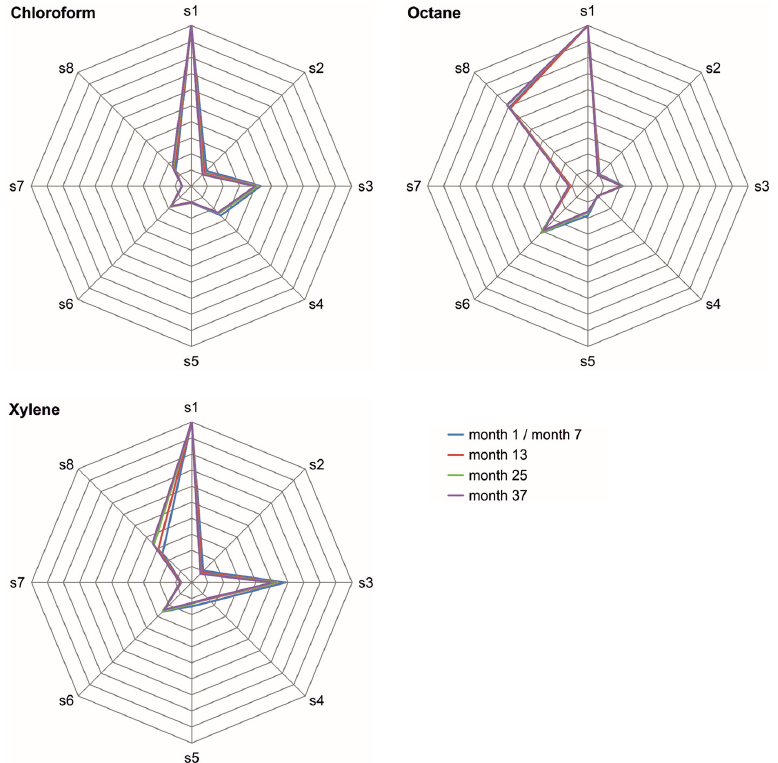
Figure 9. Radar charts of chloroform, octane, and xylene samples obtained at (semi-)annual intervals. Chloroform and xylene measurements started at month 1, octane measurements at month 7; s1–s8 represent sensors 1–8. One representative measurement was chosen from each of the three solvent vapor concentrations; and the difference frequency shifts of all sensors were normalized to the corresponding difference frequency shift of sensor 1 (i.e., the maximum difference frequency shift; see Figure 8). The normalized difference frequencies were averaged ( n = 3). For the sake of clarity, error bars are not included.